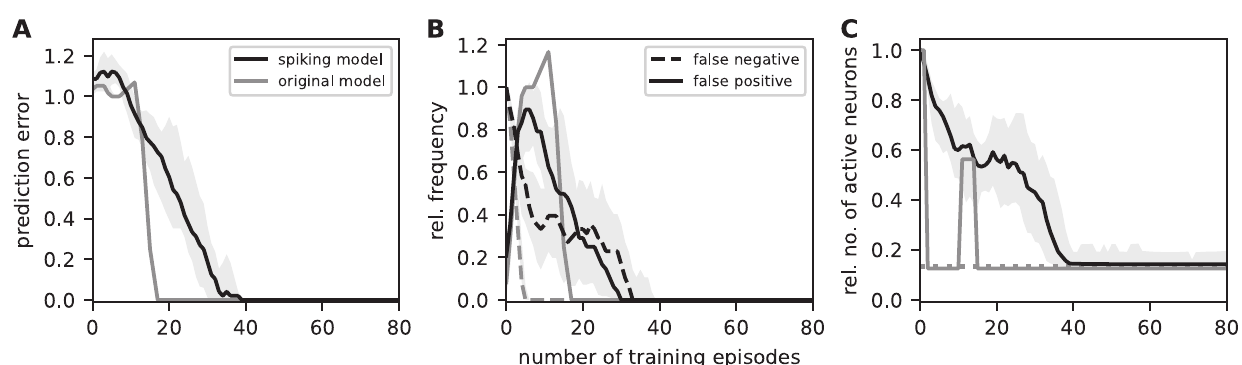
Fig 9. Sequence prediction performance for sequence set II and comparison with original model. Same figure arrangement, training and measurement protocol as in Fig 8. Data obtained during repetitive stimulation of the network with sequence set II (see Task and training protocol). Gray curves depict results obtained using the original (non-spiking) TM model from [14] with adapted parameters (see S1 Table). The dashed gray horizontal line in panel C depicts the target sparsity level ρ /( Ln E ).